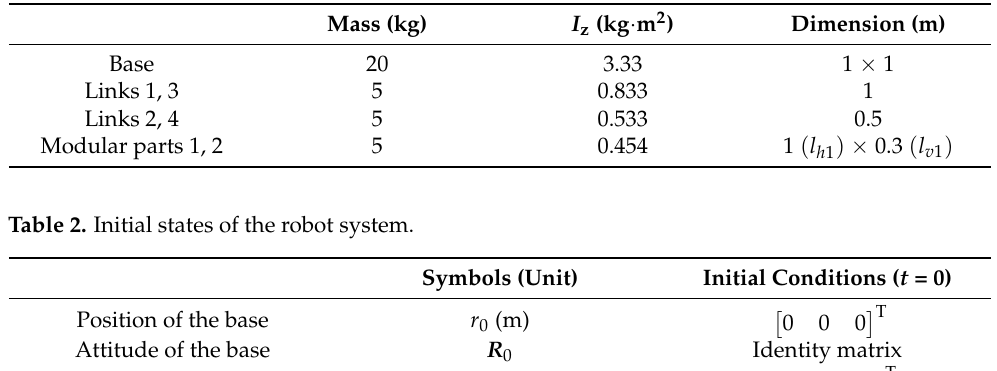
Table 1. Robot physical properties.